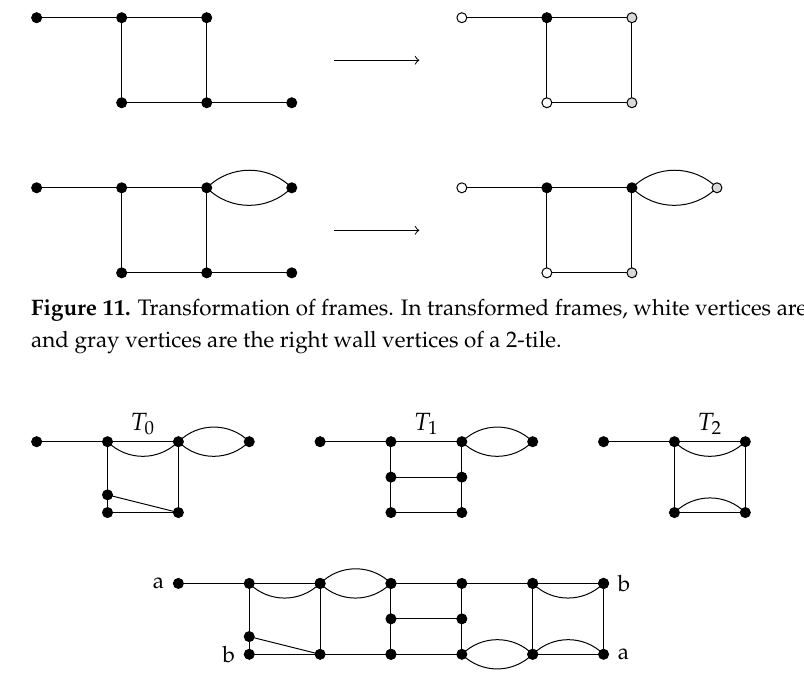
Figure 12. Graph G from Figure 5 can be obtained using modified tiles T 0 , T 1 , T 2 . The signature of this graph is sig ( G ) = DVdL HdL DDL . Later in Example 1, we show that the total number of Hamiltonian cycles in G is